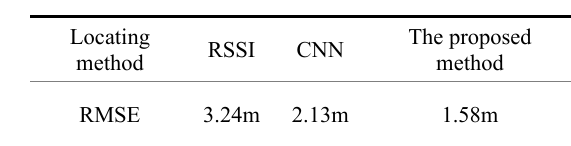
Figure 5 . (a) Experimental data acquisition framework of RSSI Bluetooth positioning framework based on FCN. (b) Actual environment for data collection. (c) Laser rangefinder